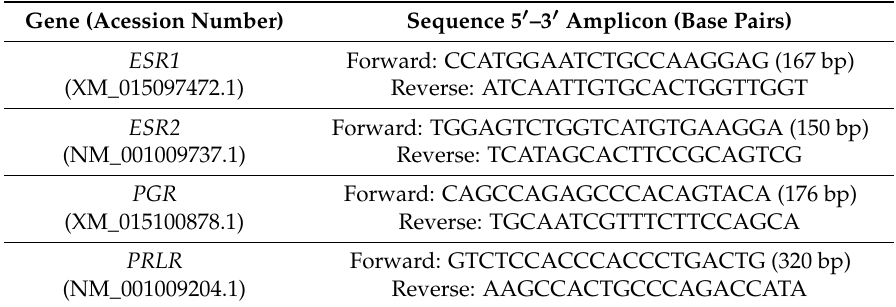
Table 1. Specific primers were designed—sequences used for quantitative real-time PCR (bp = base